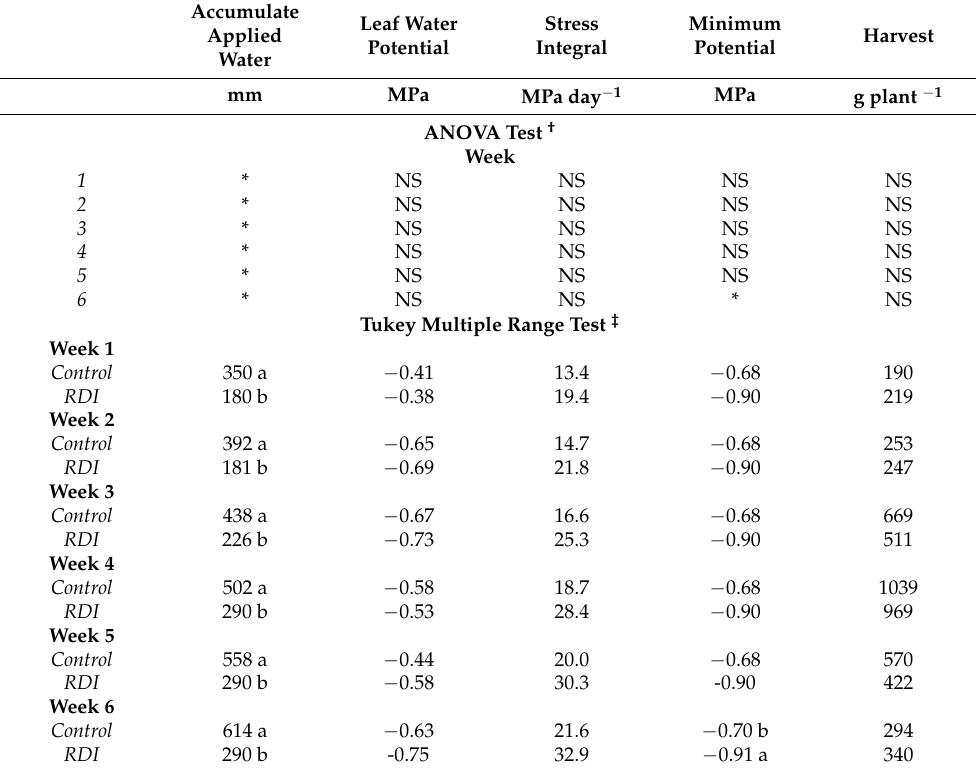
Table 1. Fruit yield and crop water